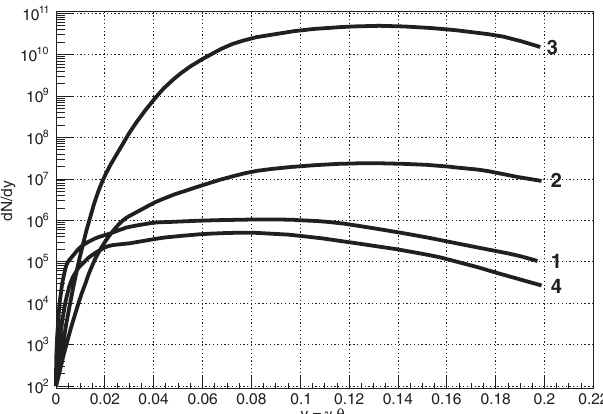
FIG. 1. The angular distributions of CXBR, CXTR, CXRTR, and CXDR (curves 1, 2, 3, and 4,